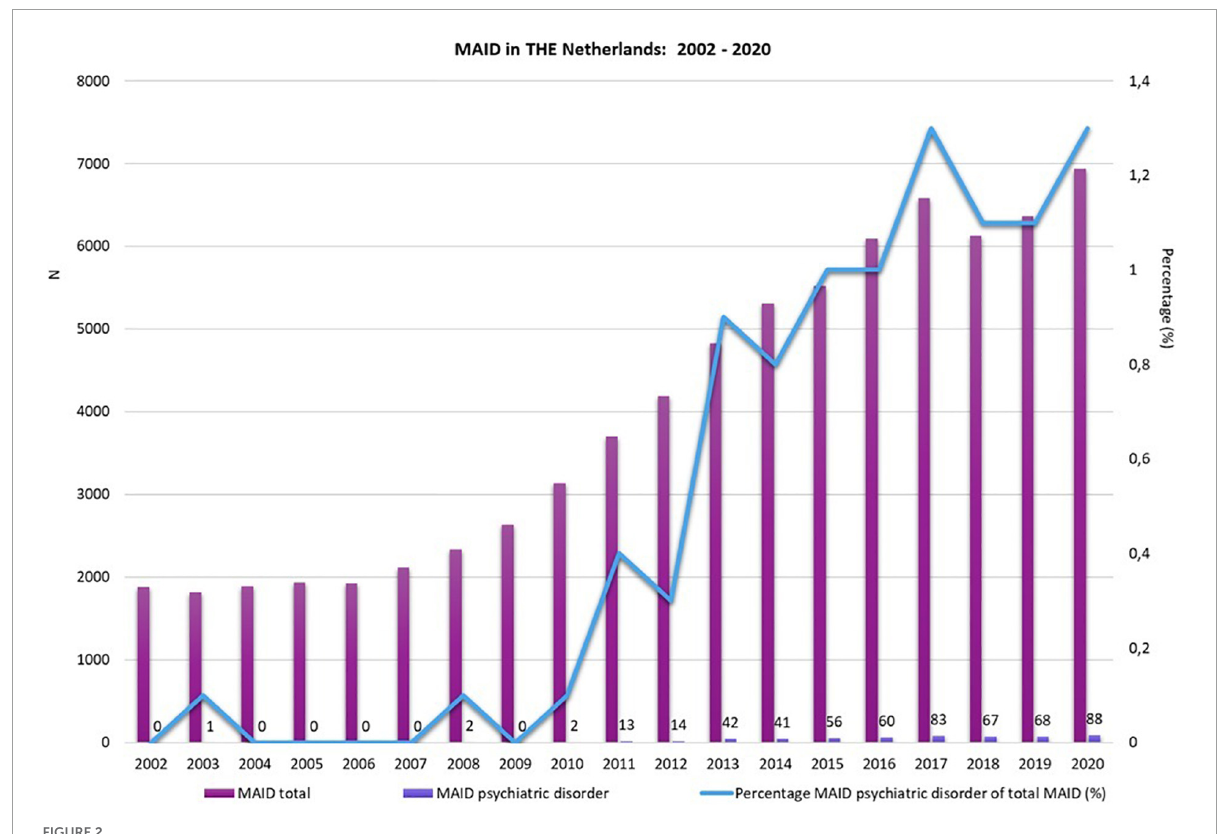
FIGURE2 Medical assistance in dying (MAID) in The Netherlands see text footnote